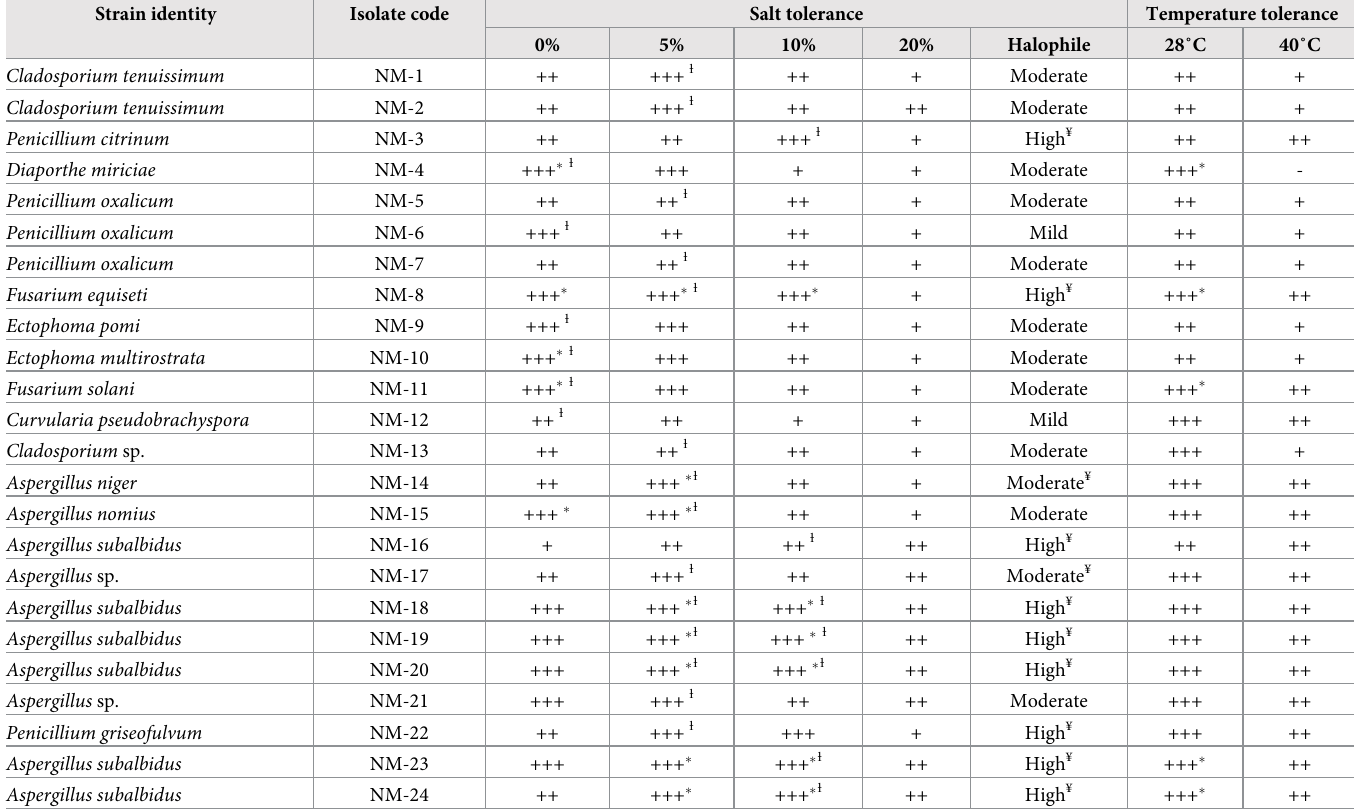
Table 3. Growth characteristics of different halophilic fungal isolates under different physiological conditions (NaCl and